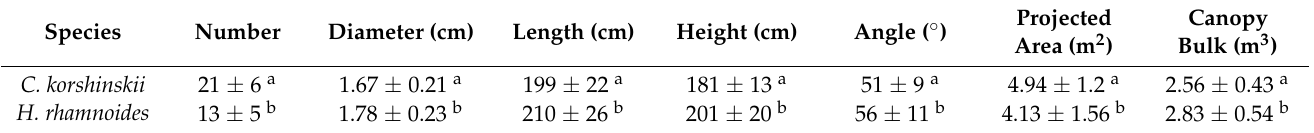
Table 2. The characteristics of 12 sampled C. korshinskii individuals and 12 H. rhamnoides individuals in the